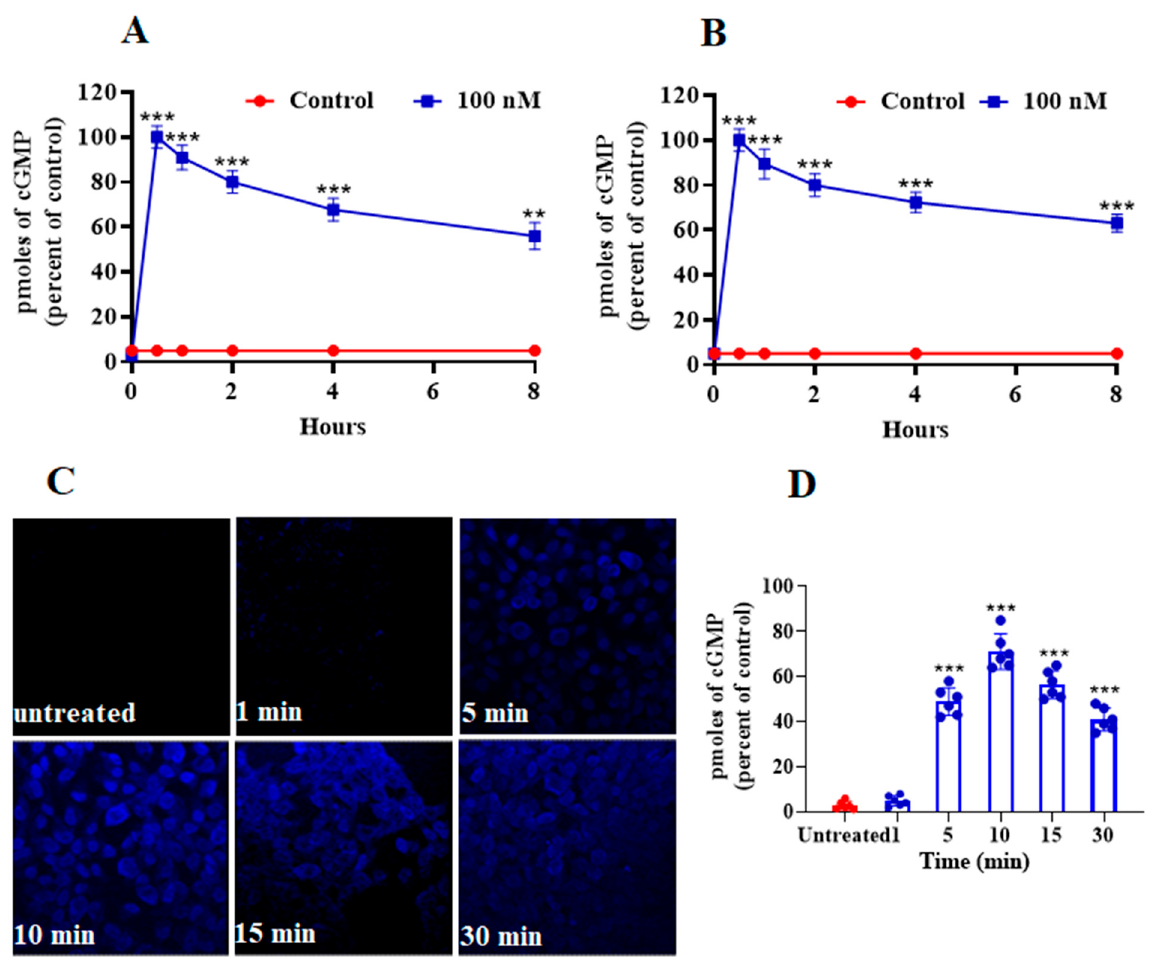
Figure 5. Effect of ANP pretreatment on the synthesis and immunofluorescence analysis of cGMP in HEK-293 and MA-10 cells. To assay the stimulation of intracellular accumulation of cGMP, ( A ) HEK-293 cells and ( B ) MA-10 cells were treated with 100 nM ANP for different times (0, 2, 4, 6 and 8 h) in the presence of IBMX and cGMP was assayed by ELISA as described in the section 4. ( C ) Untreated cells stained with DyLight™405 anti-rabbit antibody without prior incubation with the first rabbit antiserum. Cells were treated with ANP for 1, 5, 10, 15 or 30 min, which showed the accumulation of cGMP (blue). ( D ) Bars represent the densitometric analysis of the cGMP fluorescence intensities. Values represent means ± SE of 6 independent experiments. Images of mid-focal planes were used from 6 independent experiments. ** p < 0.01, *** p < 0.001 (untreated vs. drug-treated group).